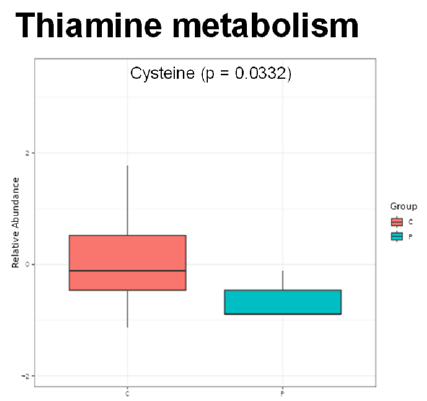
Figure A6. Detailed results of the enrichment analysis in Figure 5b. In each box plot, C and P indicate the data without and with depressive episodes, respectively.